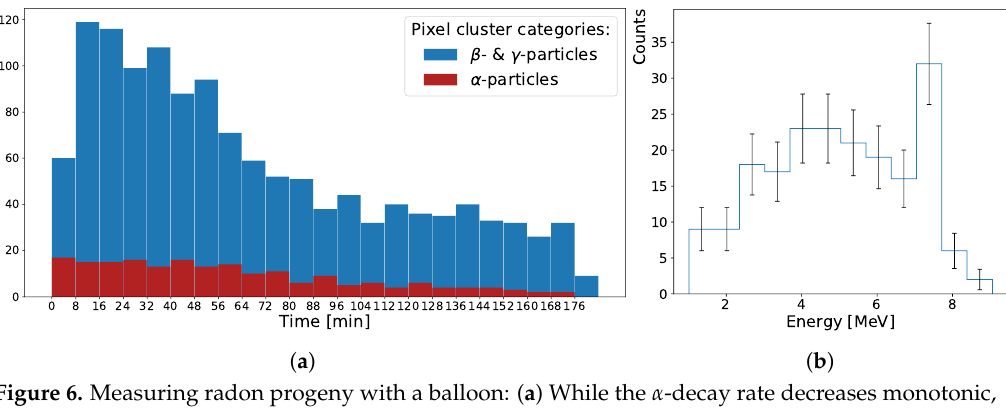
Figure 6. Measuring radon progeny with a balloon: ( a ) While the α -decay rate decreases monotonic, the β − / γ particle rate builds up as products of the short lived polonium parent. The last bin on the right shows the background rate, without balloon. ( b ) The sparse energy spectrum of the α -particles corresponds to the different isotopes of polonium. Its upper limit suggests energies are overestimated given the air gap between balloon and pixel detector surfaces. The correction from [26] was